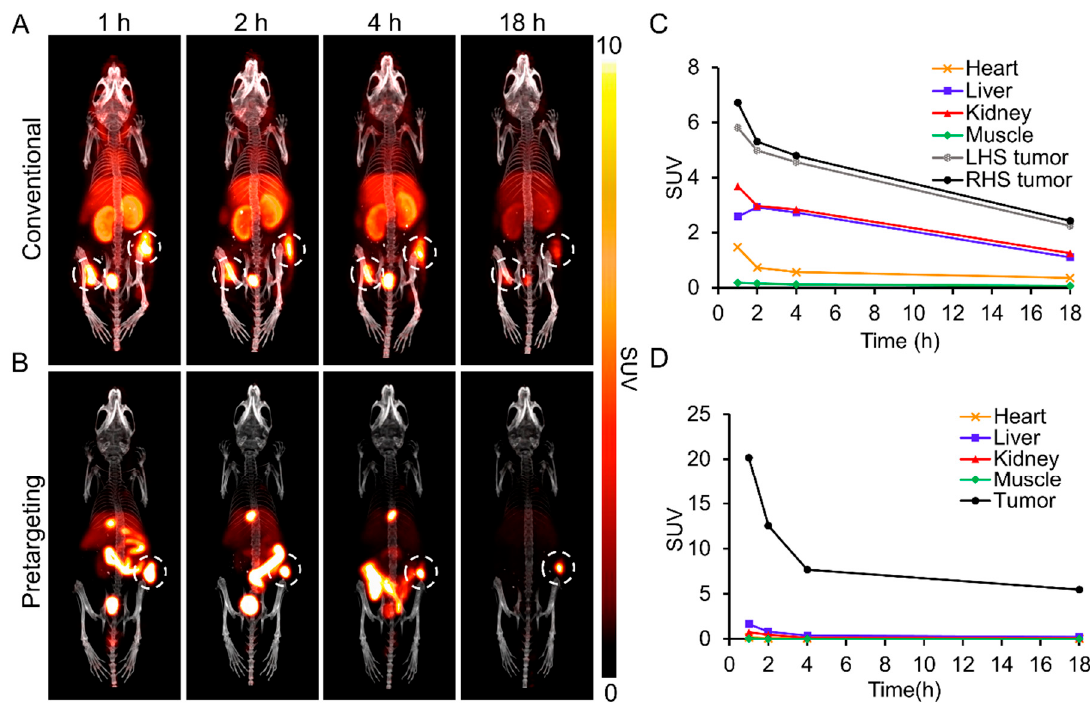
Figure 4. Maximum intensity projection PET/CT images of conventional ( A ) and pretargeting strategies ( B ) in female nude mice bearing MDA-MB-231 tumor xenografts. PET-quantified standardized uptake values of conventional and pretargeting strategies ( C , D ), respectively ( n = 1 each). 64 Cu-PCB-TE2A-Tz was administered 48 h after administration of hnRNP-PEG 4 -TCO for the pretargeting strategy. Xenografts are highlighted by a white dashed circle.